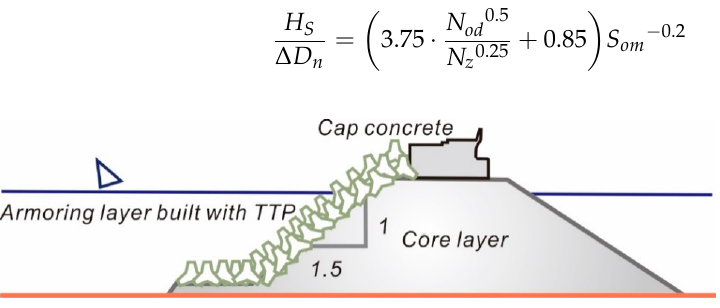
Figure 2. Schematic sketch of rubble mound breakwater armored by two layers of tetrapod (TTP). In Equation